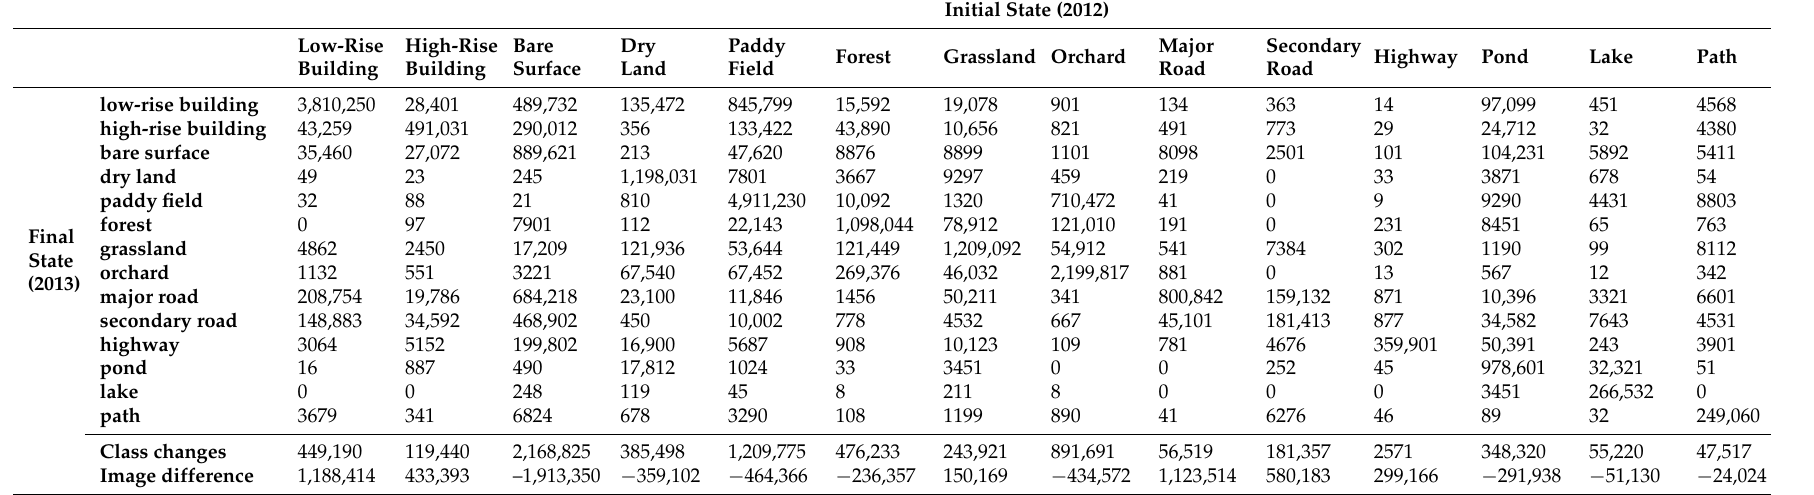
Table 3. The matrix of land cover changes between 2012 and 2013. The unit is m 2